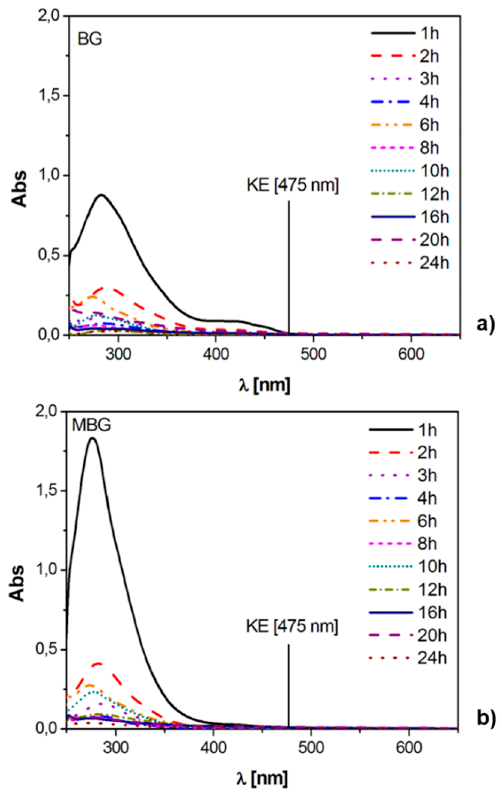
Figure 6. UV-Vis spectra in SBF of ( a ) BG and ( b ) MBG samples loaded with K2T23.